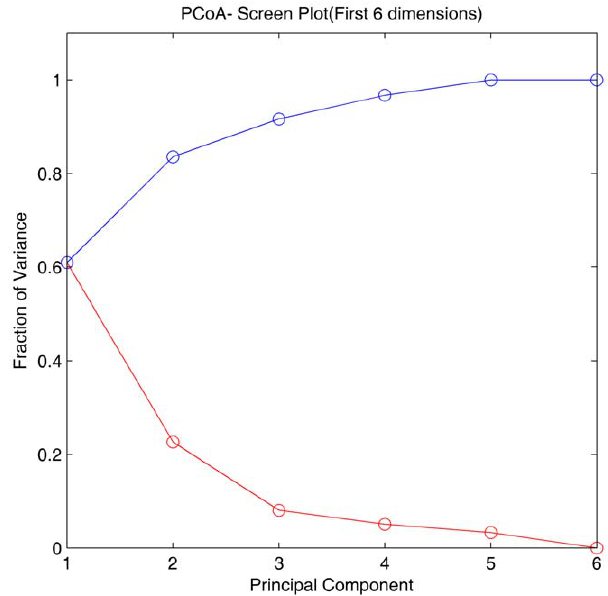
Figure 7. Principal Coordinates Analysis (PCoA) of weighted UniFrac values between control and infected animals ( N =3): The fraction of variance by the first six dimensions, both individually (red) and cumulatively (blue).